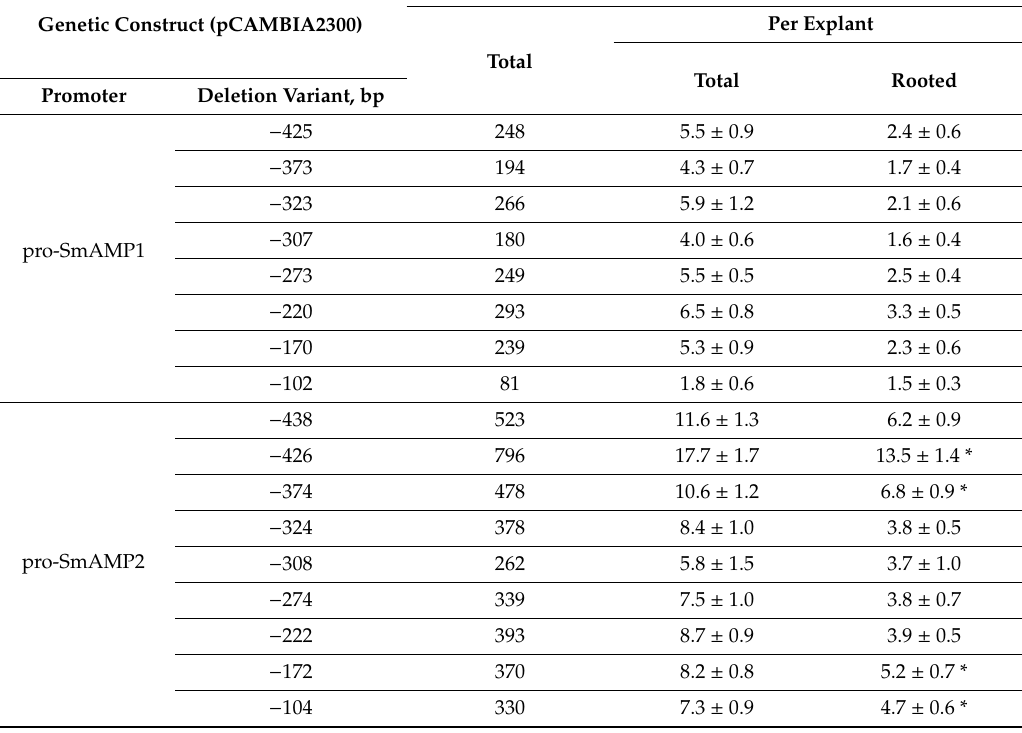
Table 1. E ffi ciency of regeneration and selection of transgenic tobacco shoots (mean ± SD) with various deletion variants of the pro-SmAMP1 and pro-SmAMP2